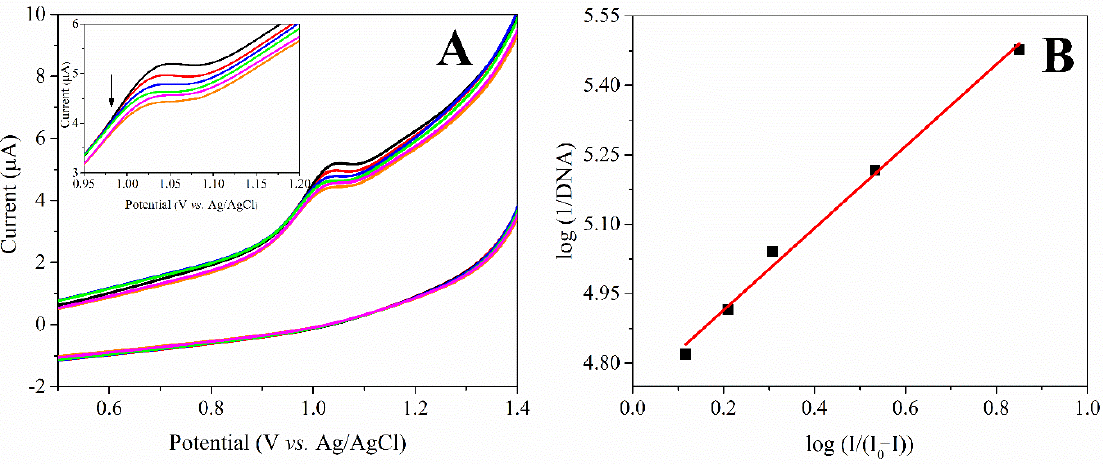
Figure 4. ( A ) Cyclic voltammograms of 10 μg mL −1 CIN and in the presence of ct-dsDNA in the range of 3.30 × 10 −6 M – 1.50 × 10 −5 M, ( B ) Related plot of log (1/[DNA]) vs. log (I/(I 0 − I)).